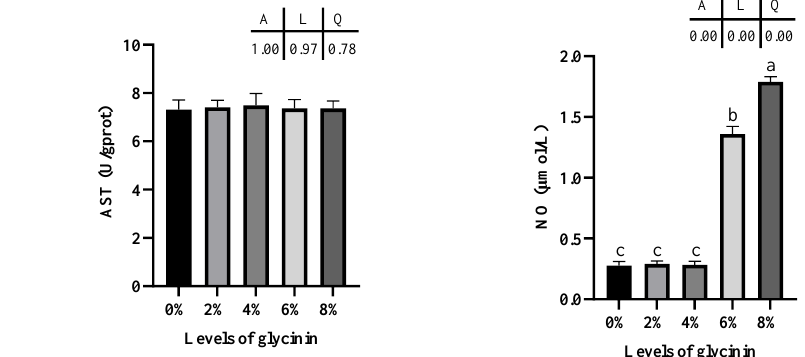
indicated by a, b and c ( p < 0.05). A represent the variance analyzed by one-way ANOVA; L repre- sent linear trend analyzed by orthogonal polynomial contrasts; Q represent quadratic trend ana- lyzed by orthogonal polynomial contrasts.